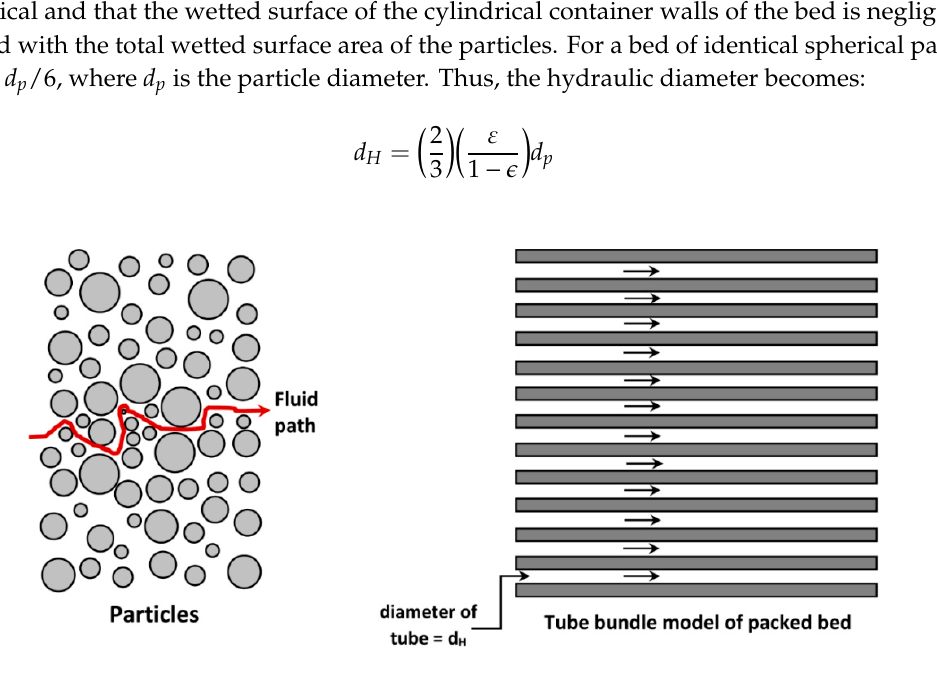
Figure 4. Path taken by fluid in a bed of particles and tube bundle model of packed bed.